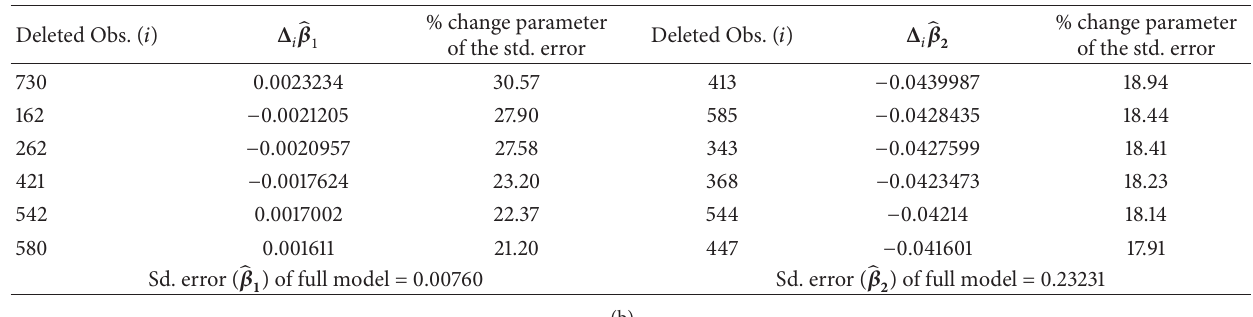
̂ 𝛽 ̂ 𝛽 ̂ 𝛽 ̂ 𝛽 1 ), TBC ( 2 ), HIV ( 3 ), and age by HIV ( 4